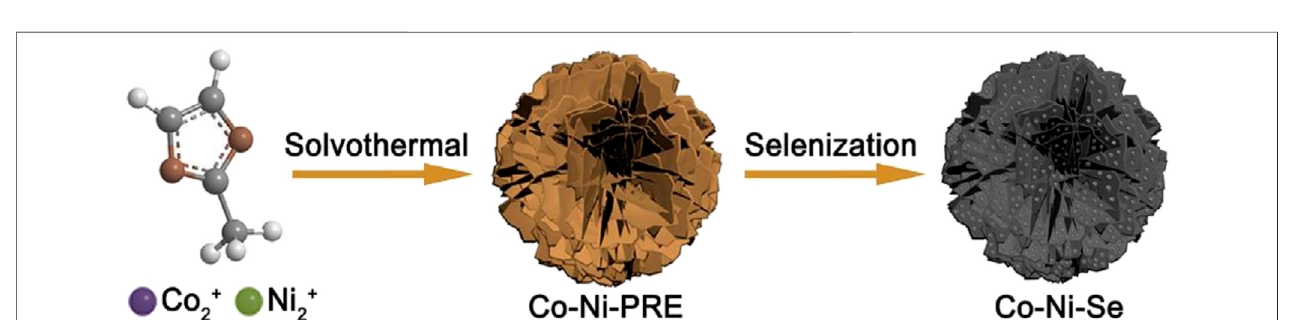
FIGURE 6 | Schematic illustration of Co-Ni-Se NFs